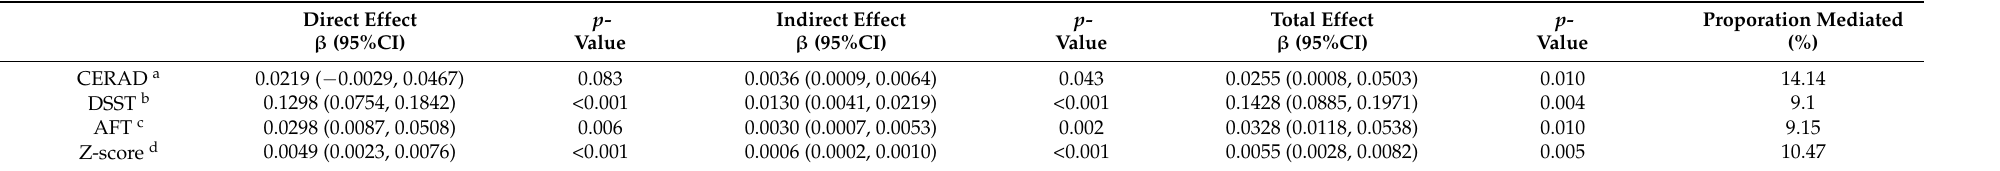
Table 5. The mediating proportion of depressive symptoms on the association between AHEI-2010 and cognitive